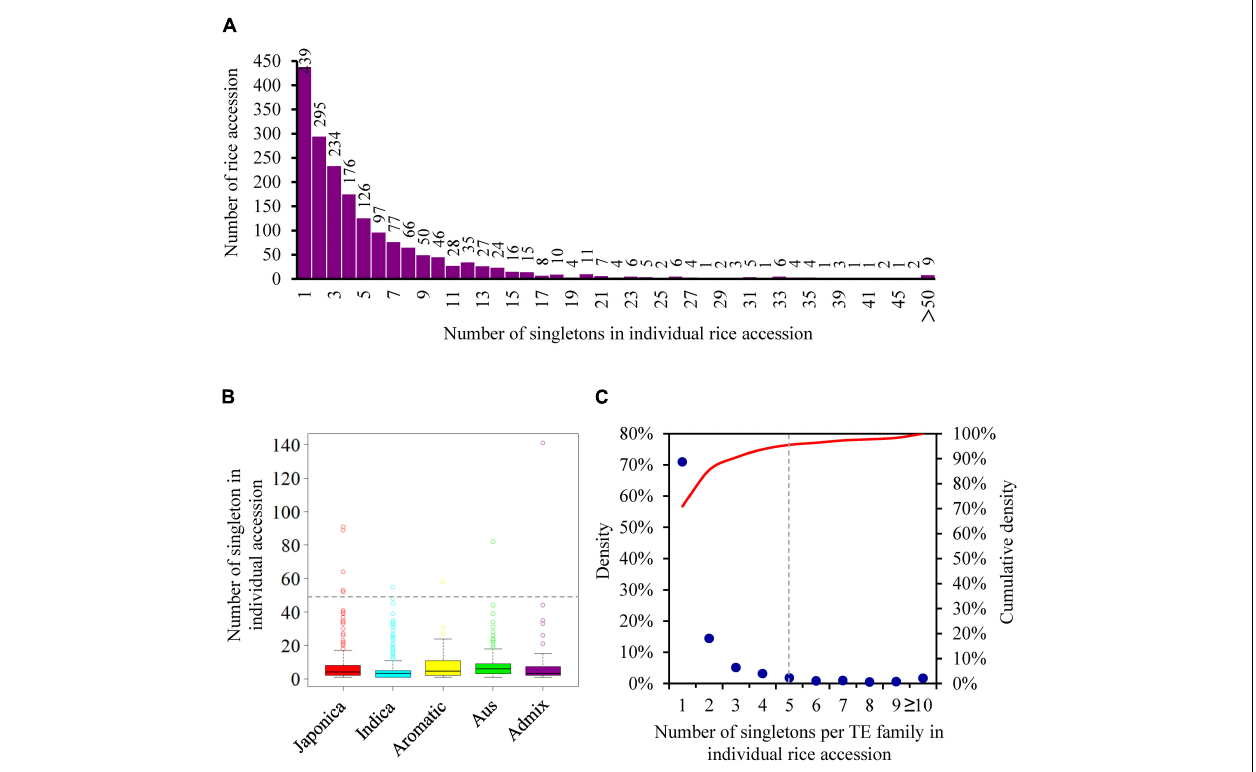
FIGURE 3 | The distribution of singletons among different rice accessions. (A) The distribution of the number of singletons in individual rice accession; (B) the distribution of the number of singletons in rice accession from five distinct groups. Each boxplot shows the distribution of the number of singletons owned by each rice accession in the corresponding group. The median represented the middle number of singletons among all rice accession from the same group. The number corresponding to the gray dashed line is 50; (C) the distribution of the number of singletons per TE family in individual rice accession. The red curve represented the cumulative